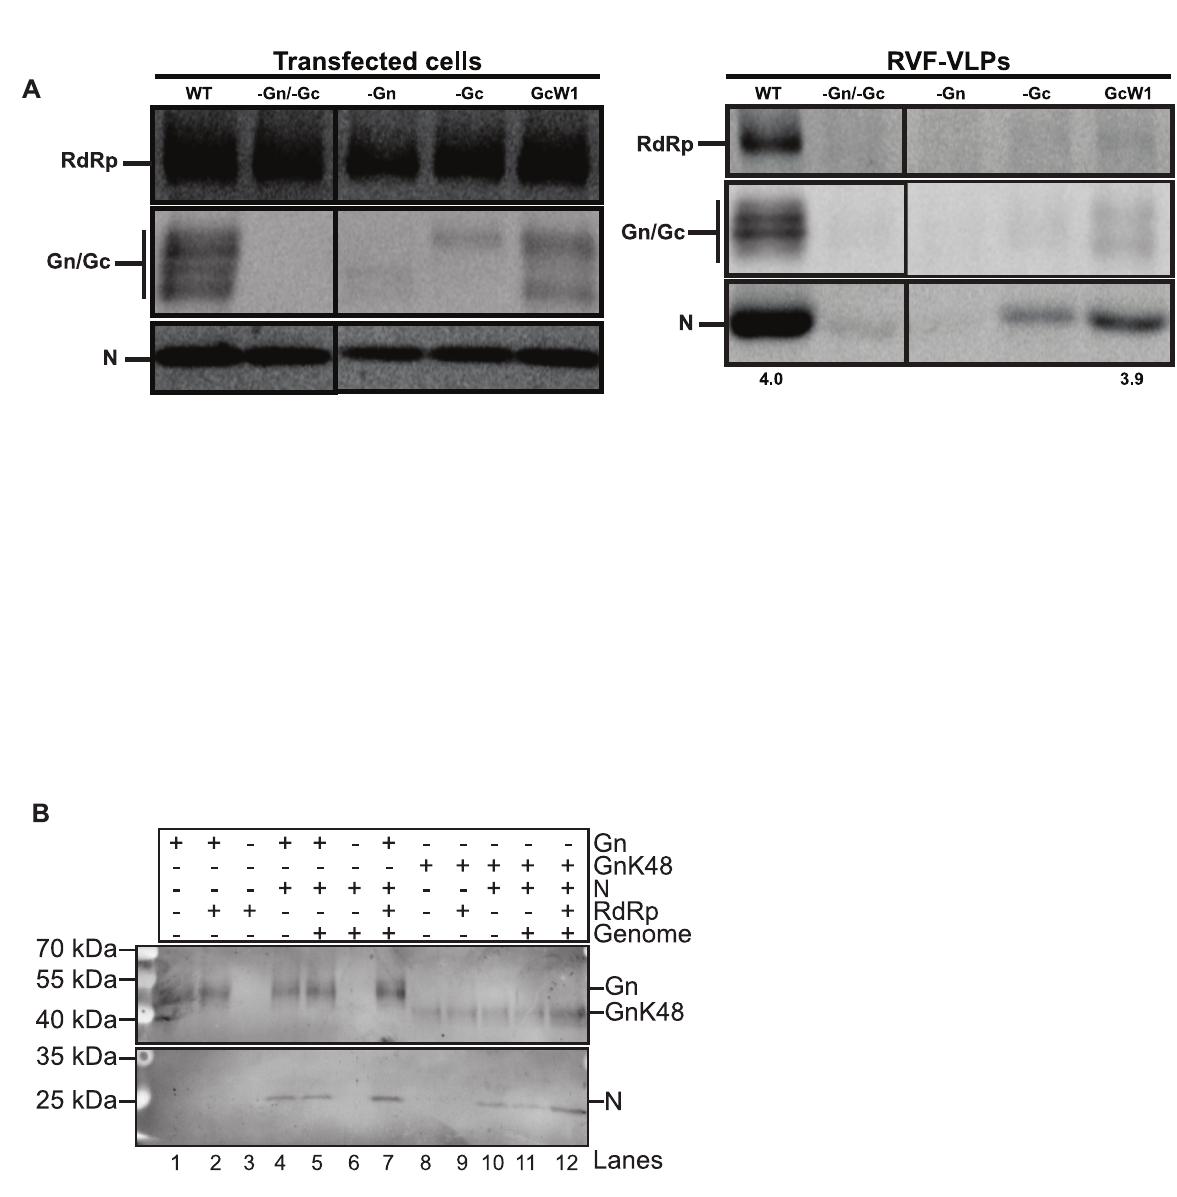
Figure 5. Gn packages N. A. BSR-T7/5 cells were transfected with genome and all of the structural proteins (WT), or one or more of the components was replaced with an equivalent amount of empty vector, (-Gn/-Gc, -Gn, or -Gc) or a plasmid expressing an allele of Gc that lacks the entire cytoplasmic tail (GcW1). Transfected cells were analyzed for protein expression by immunoblot. RVF-VLPs were immune precipitated from the clarified media from transfected cells and analyzed by immunoblot. The numbers below the immunoblots indicate the ratio of glycoprotein to N signal. B . BSR-T7/5 cells were transfected with the indicated plasmids and proteins were cross-linked at 48 h post-transfection. Mouse monoclonal anti-Gn antibodies were used to immune-precipitate Gn containing complexes. The cross-links were cleaved and then Gn-containing complexes were identified by immunoblot using rabbit anti-Gn or rabbit anti-N antibodies.